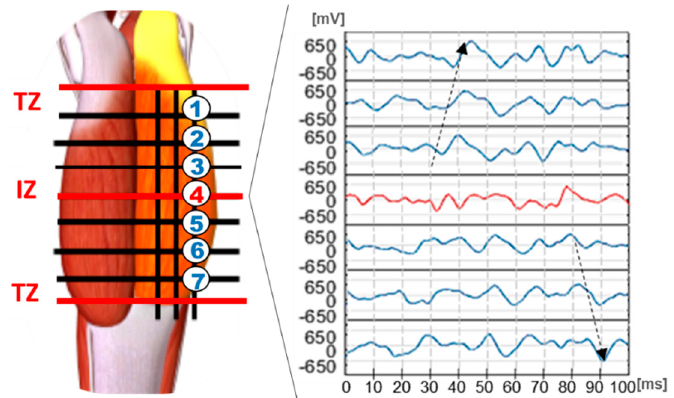
Figure 2. Surface Electromyography (EMG) positioning lattice with detailed EMG acquisition on seven selected sites. The waveforms refer to an experimental acquisition (Subset 2 – dataset: gait exercise- time window: 100 ms).